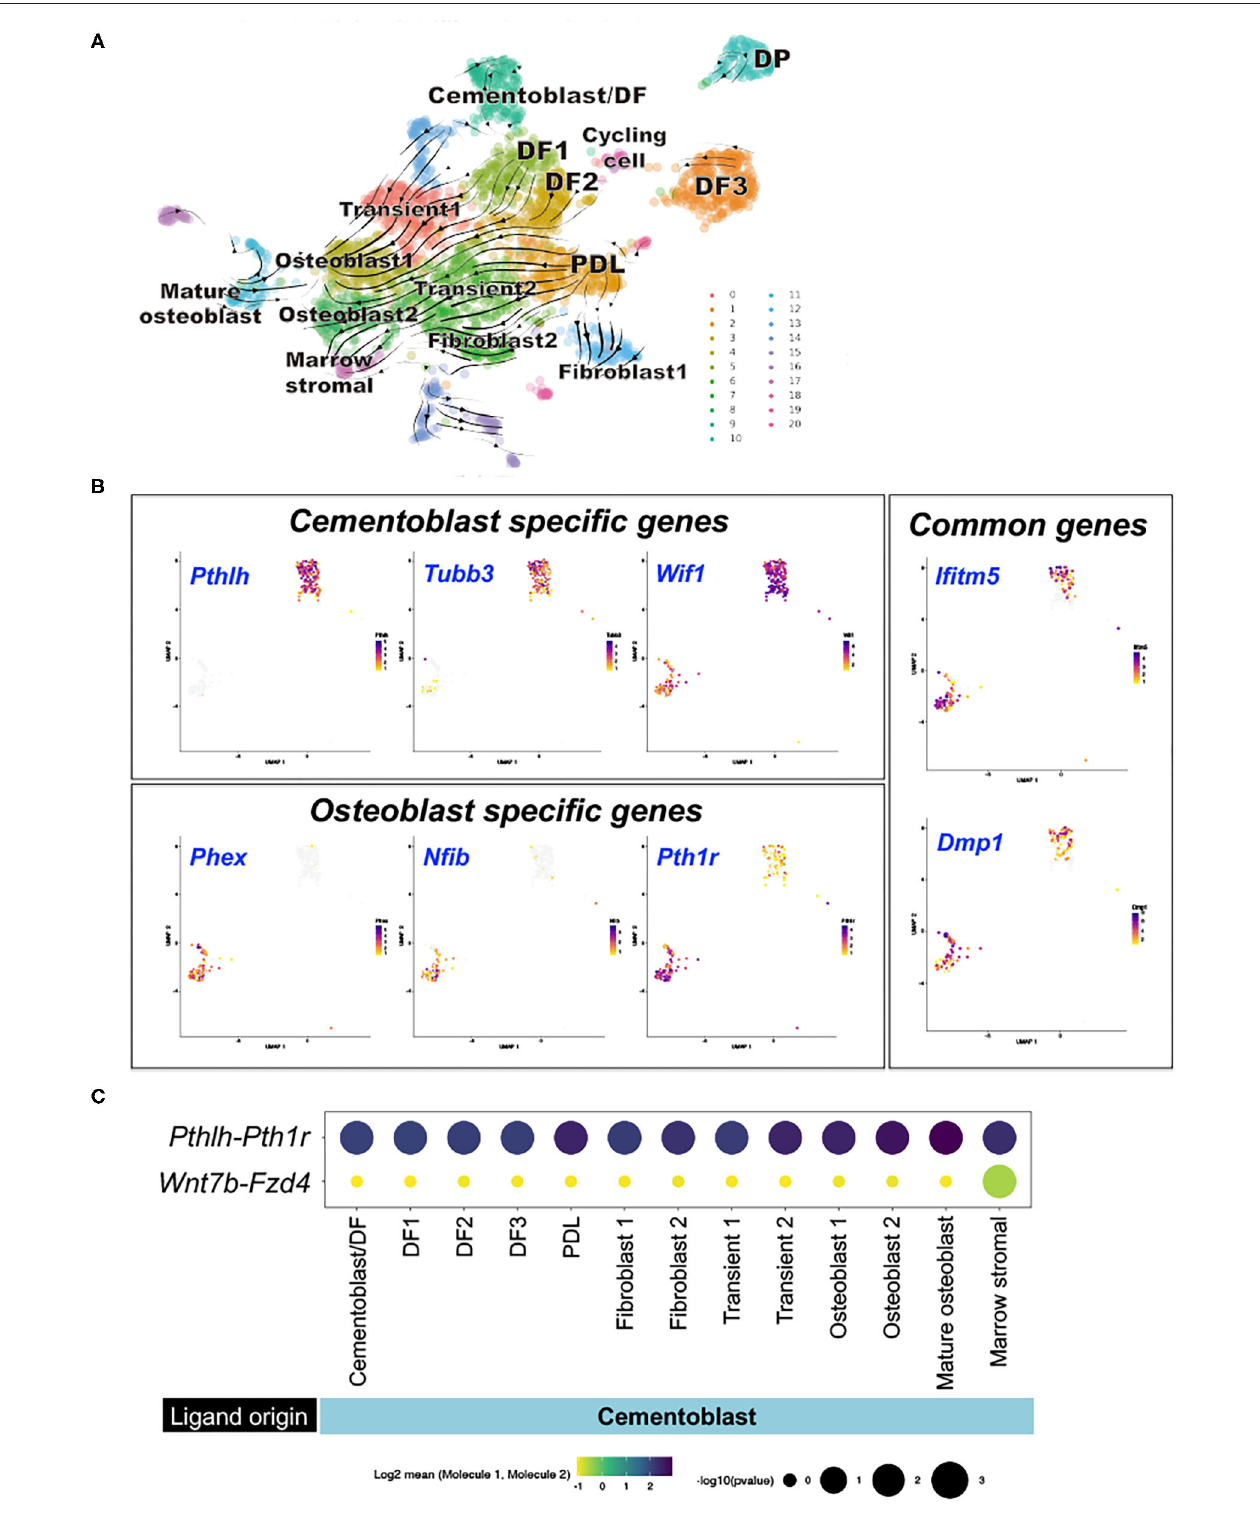
FIGURE 3 | Computational lineage inference and intercellular communications of subset of PTHrP-mCherry + DF cells and Col1a1-GFP + periodontal cells. (A) RNA velocity analysis. Left panel: Dynamic velocity vectors superimposed on UMAP plot. Arrows: dynamic velocity vectors predicted future cell states. Right panel: cells colored by sample, (B) Comparison DEGs between cluster 9 and 11. Wilcoxon signed-rank test was conducted to identify differentially expressed genes. High